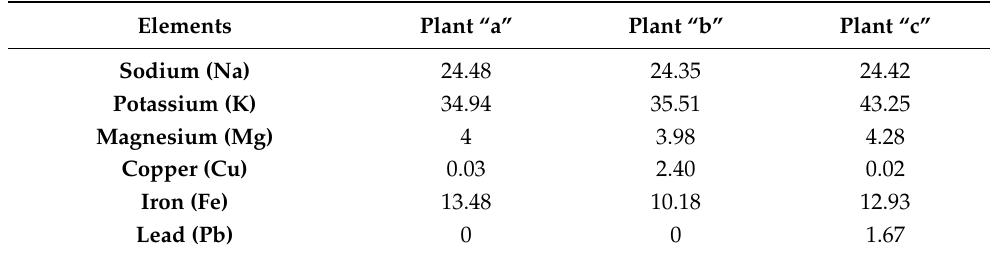
Table 4. Elemental analysis of S. oleracea for control leaf plant “a”, Copper stress leaf plant “b”, and Lead stress leaf plant “c” through Atomic Absorption